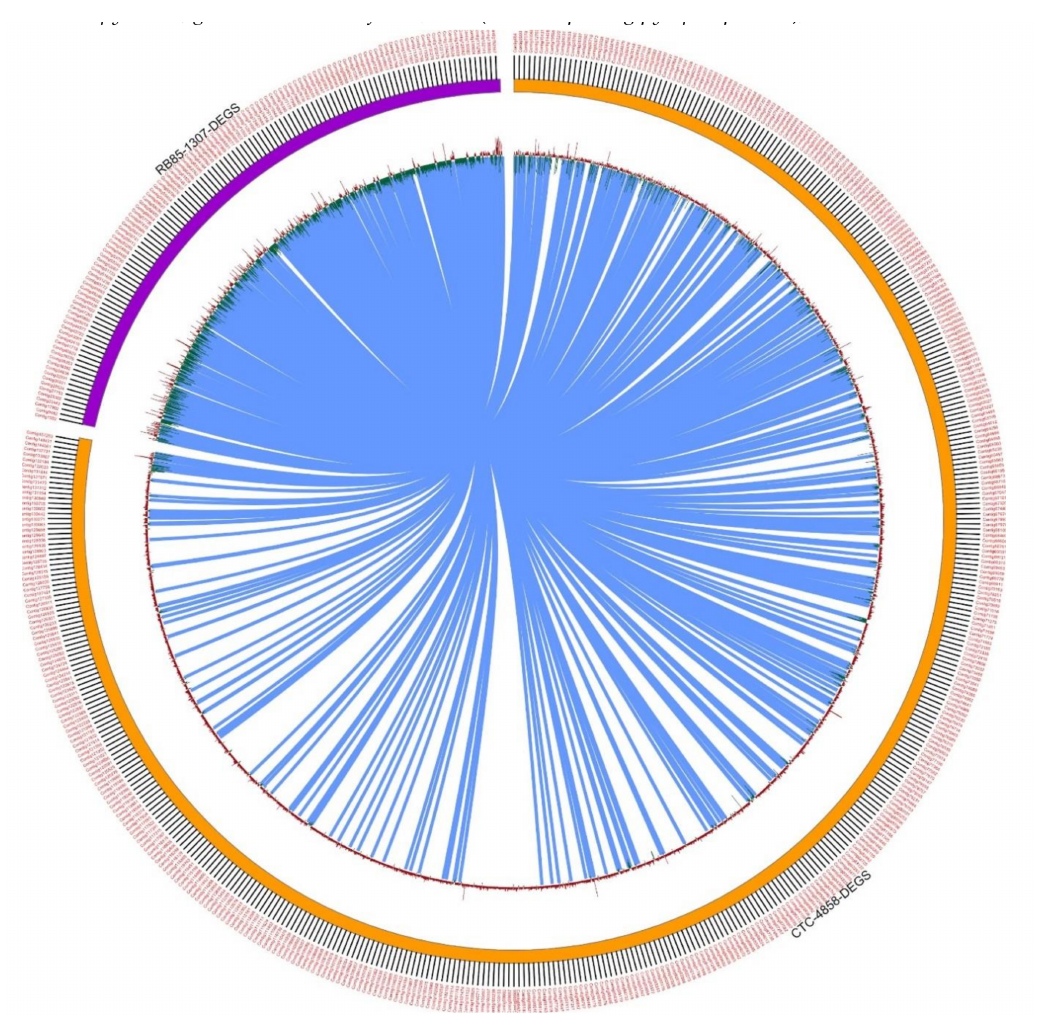
Figure 5. Circular visualization (Circos) plot showing di ff erentially expressed genes showing shared biological processes for TAS and SAS. Two comparisons are plotted: CTC-2 control vs. treated with 4858 di ff erentially expressed genes, and RB855453 control vs. treated with 1307 di ff erentially expressed genes. Points that represent common contigs are graphically connected. From DEG analysis (Section 2.4), 4858 di ff erentially expressed genes were identified for the TAS treatment vs. control (color-coded orange half of the pie) and 1307 contigs were di ff erentially expressed in SAS treatment vs. control (color-coded purple half of the pie), while 464 contigs were common between the two genotypes (represented as the connecting links depicted as light blue lines). Using this tool, a large dataset can be visualized e ffi